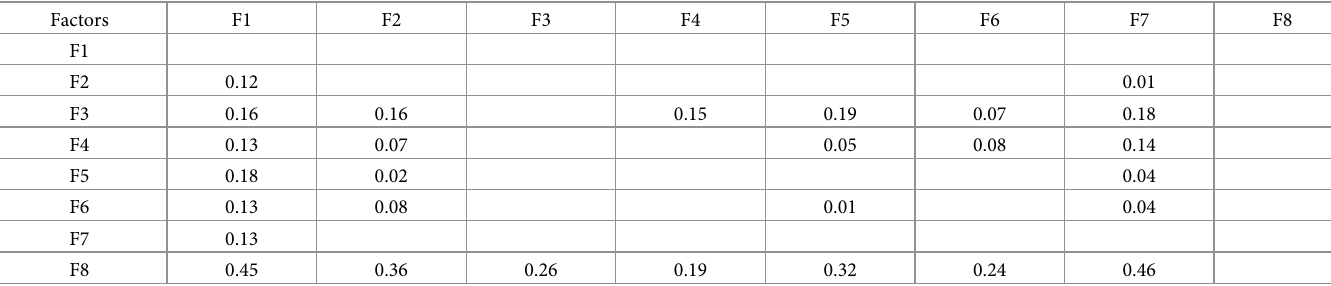
Table 7. Net influence matrix (NeT).